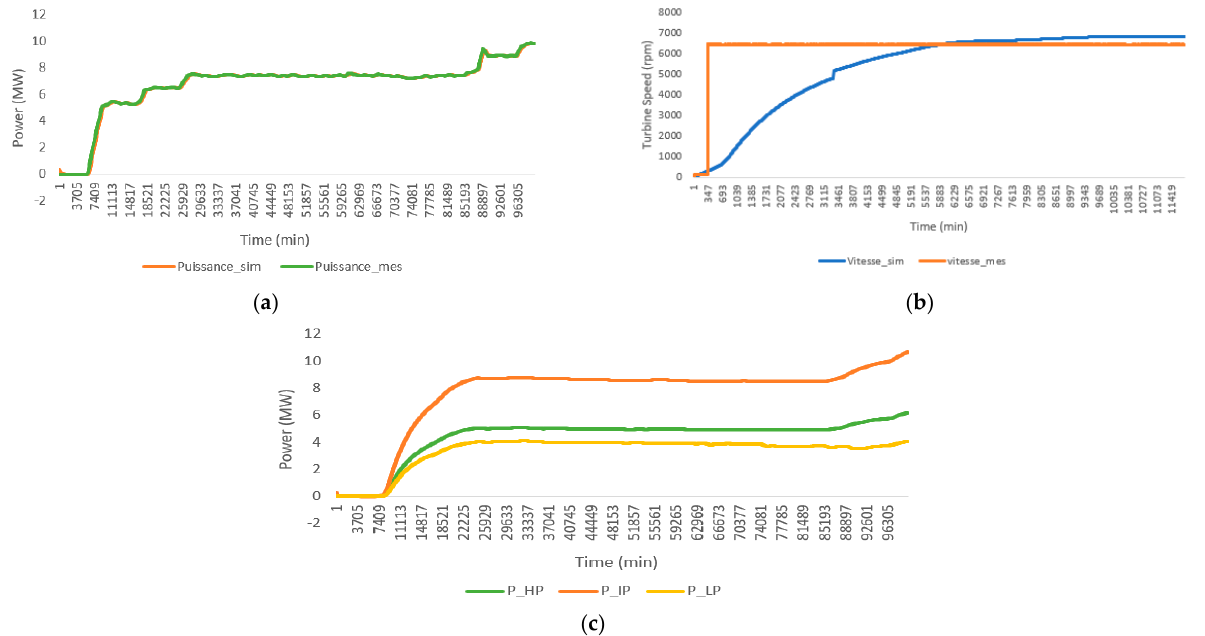
Figure 18. Steam turbine produced power. ( a ) Speed. ( b ) HP section produced power, IP section produced power, LP produced power ( c ). Simulation results are represented through Figure 19.